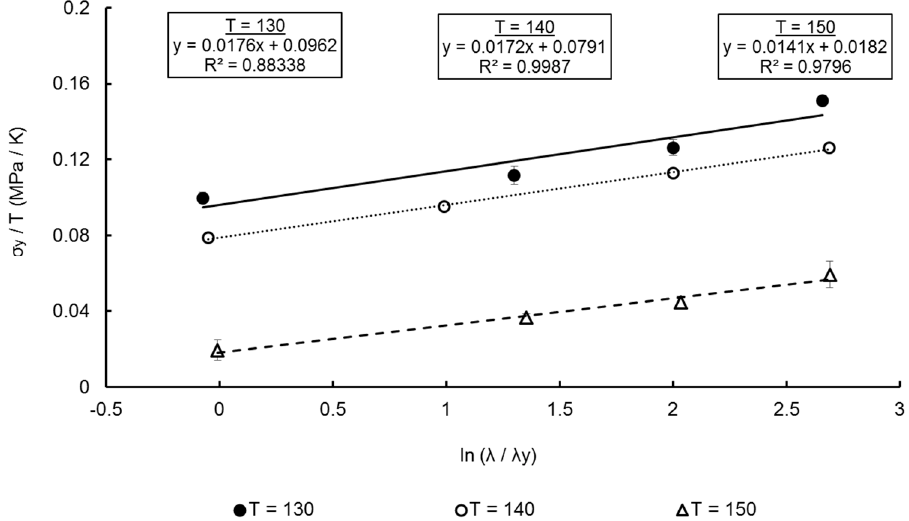
Figure 7. Eyring plots for EB deformation of PEEK between temperatures of 130–150 °C, at a nominal strain rate range of 1–16 s − 1